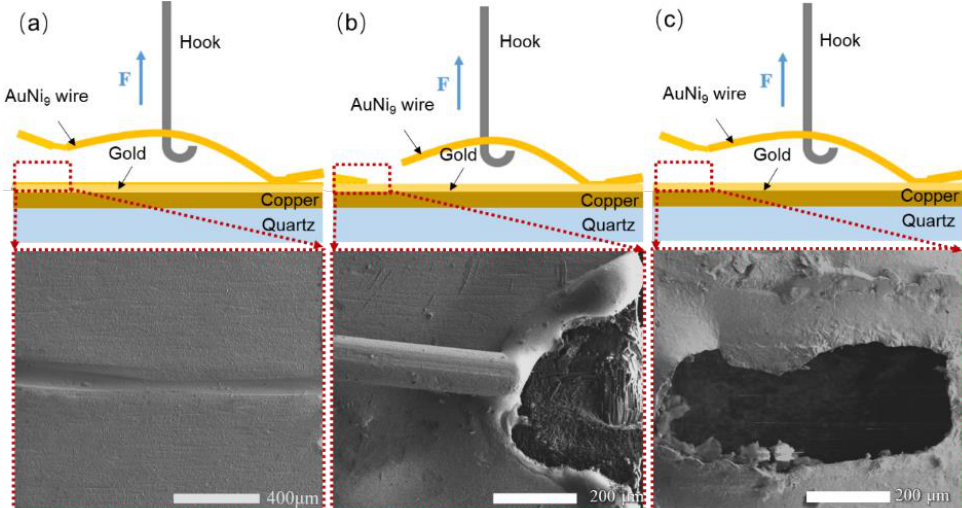
Figure 8. Schematic illustrations and corresponding fracture morphologies at ( a ) 0.200 kA, 3 ms, and 9.8 N; ( b ) 0.275 kA, 3 ms, and 28.7 N; and ( c ) 0.275 kA, 6 ms, and 9.8 N. The parameters correspond with the designations a, m, and d in Table 1, respectively.